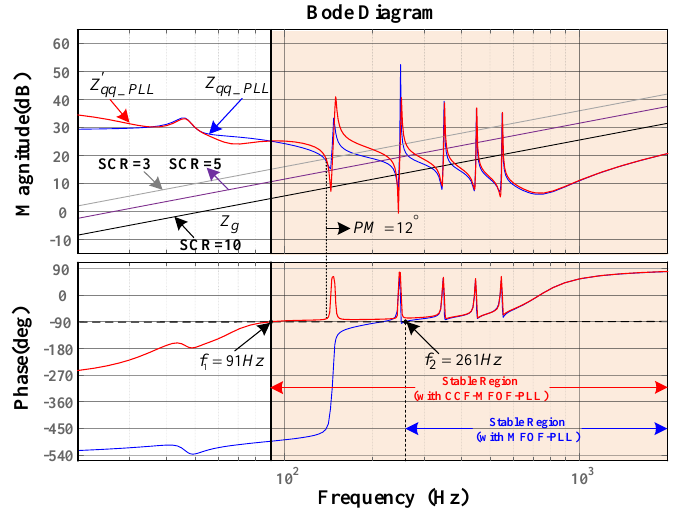
Figure 14. Bode plot of inverter and grid impedance after impedance reshaping.